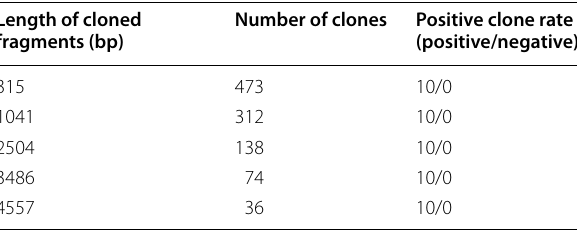
Table 2 Cloning capability and efficiency of selection-free PCRRC with pOmni Length of cloned fragments (bp)